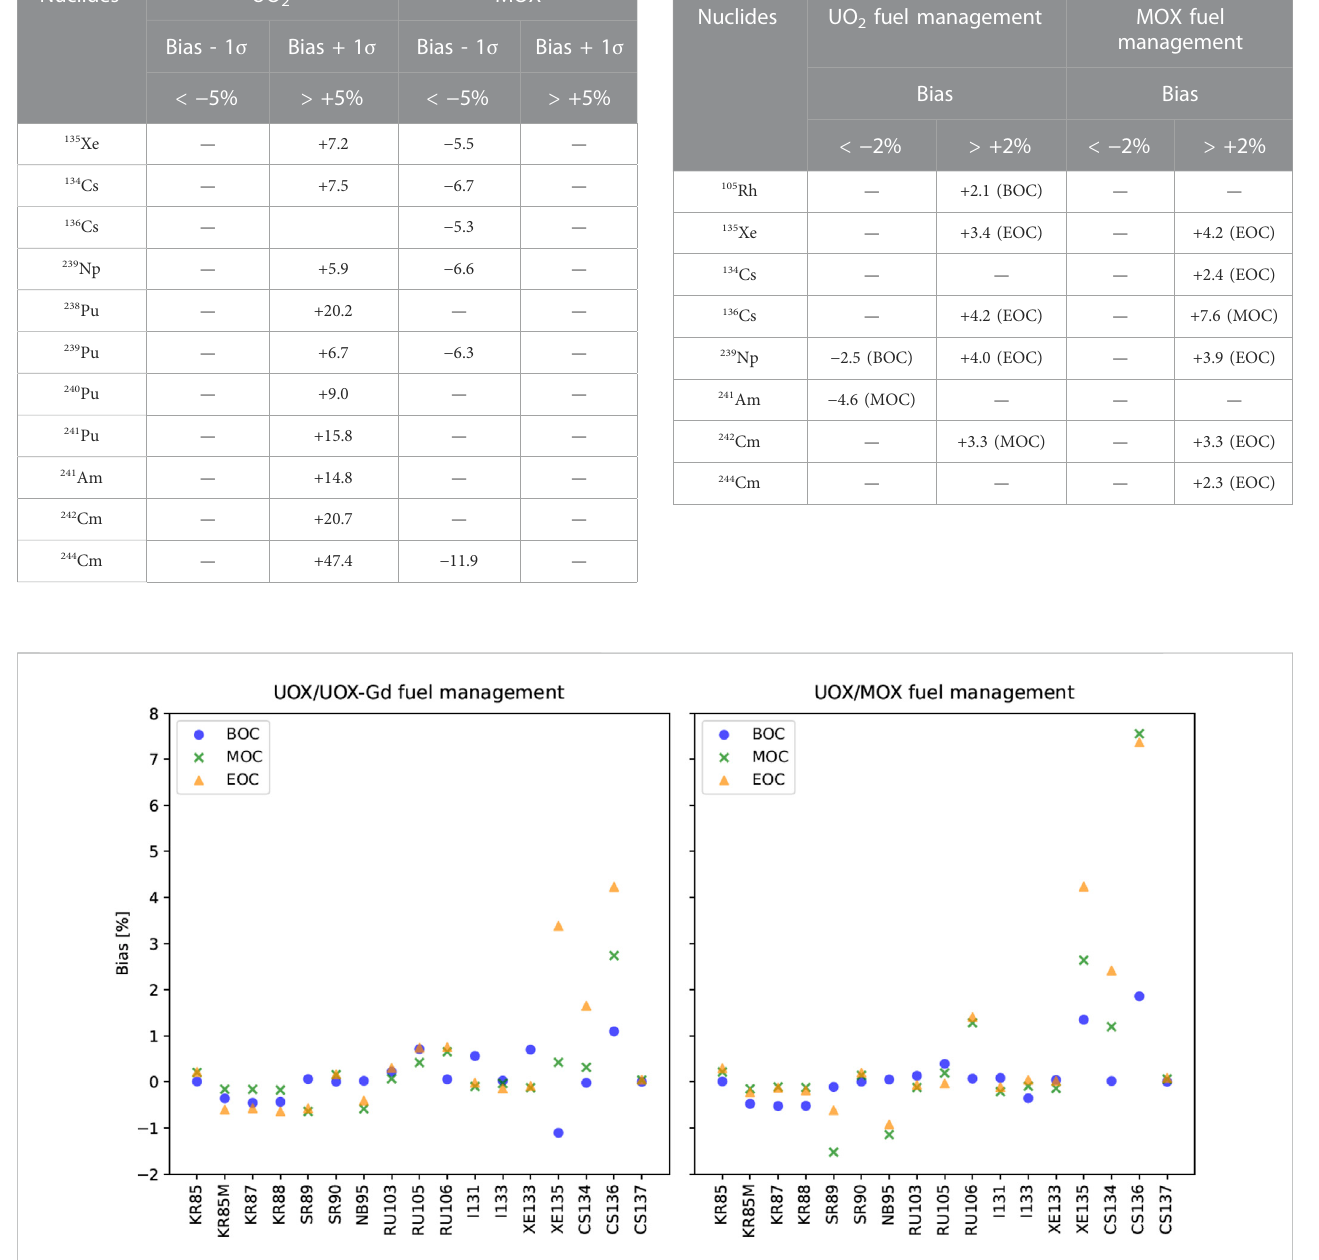
FIGURE 7 ILA bias on the core nuclide inventory, at BOC, MOC and EOC, for both UO 2 (left) and MOX (right) fuel management.